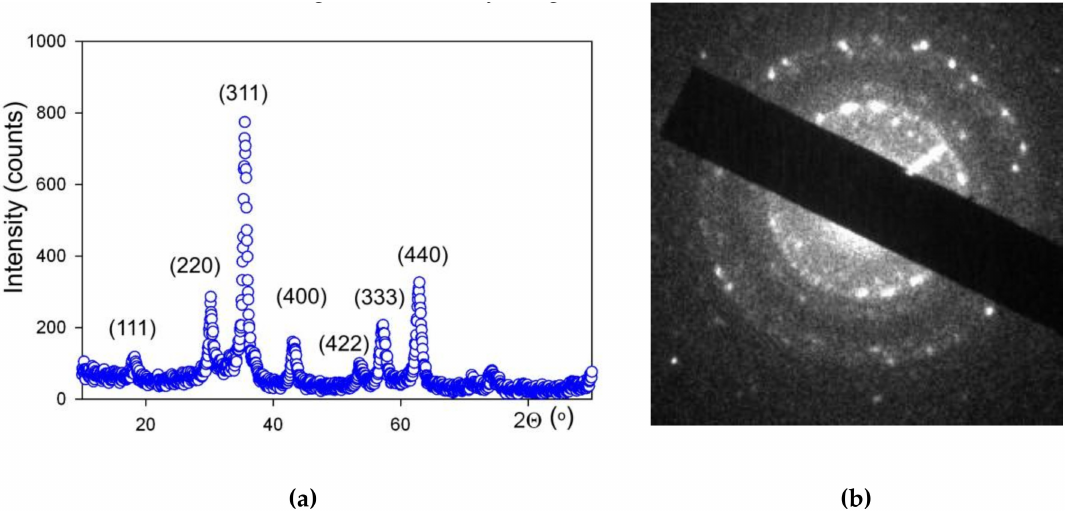
Figure 2. XRD pattern ( a ) and microdiffraction TEM image ( b ) of iron oxide magnetic nanoparticles